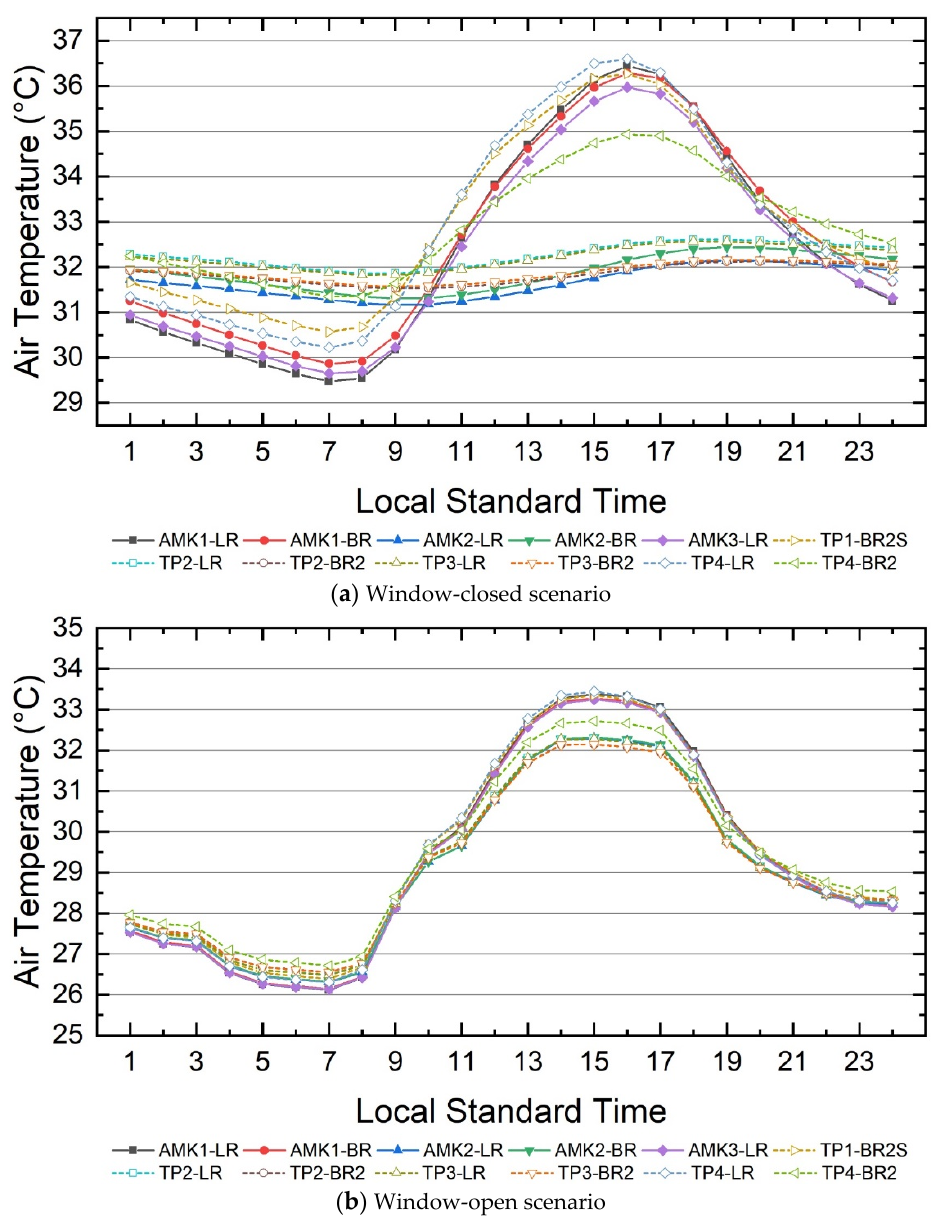
Figure 12. Hourly T a profiles of all the target zones in blocks AMK and TP: ( a ) window-closed scenario; and ( b ) window-open scenario.